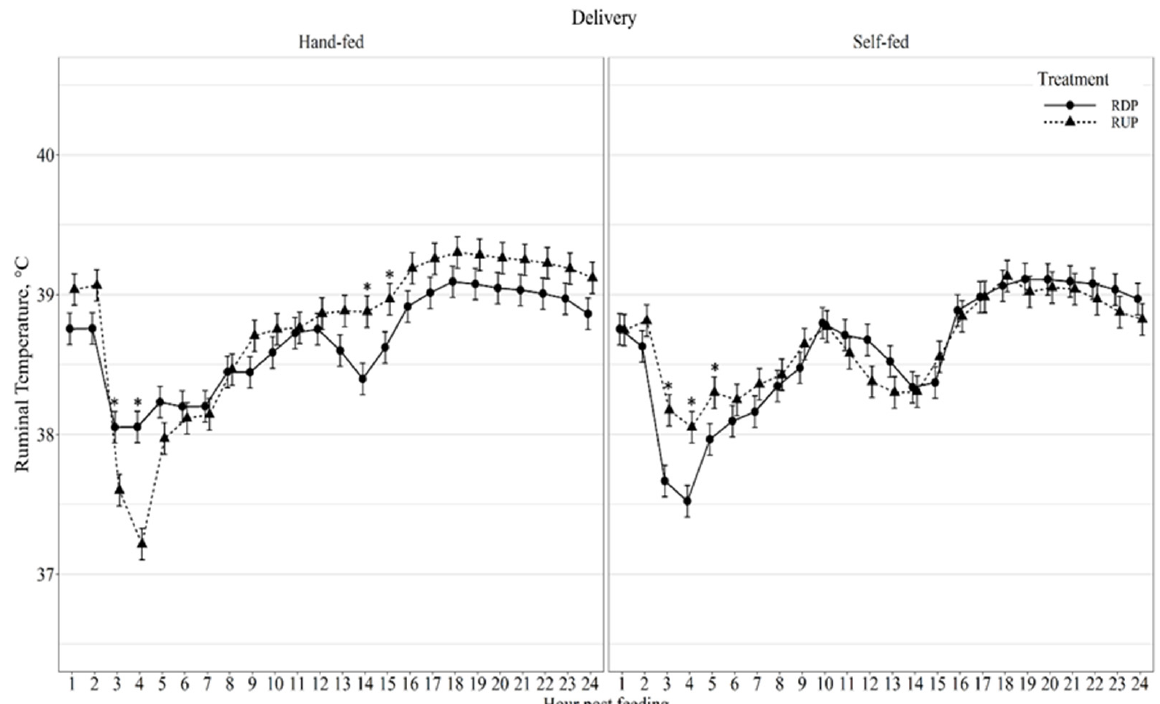
Figure 3. Diurnal ruminal temperature (°C) patterns of beef cows fed hand-fed or self-fed rumen degradable (RDP) or rumen undegradable (RUP) protein supplements with low-quality forage at 08:00. Ruminal temperature was influenced by delivery method × protein type × hour post-feeding interaction ( p < 0.01), and differences ( p ≤ 0.05) within hour post-feeding are denoted by *.